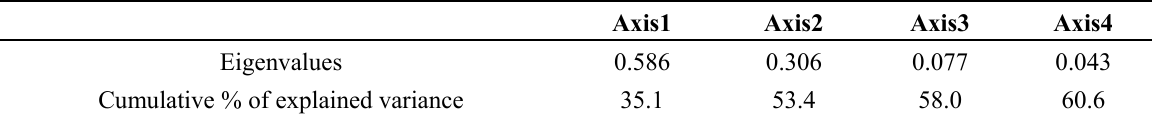
Table 6. DCA of the EFTs with the Land Use System